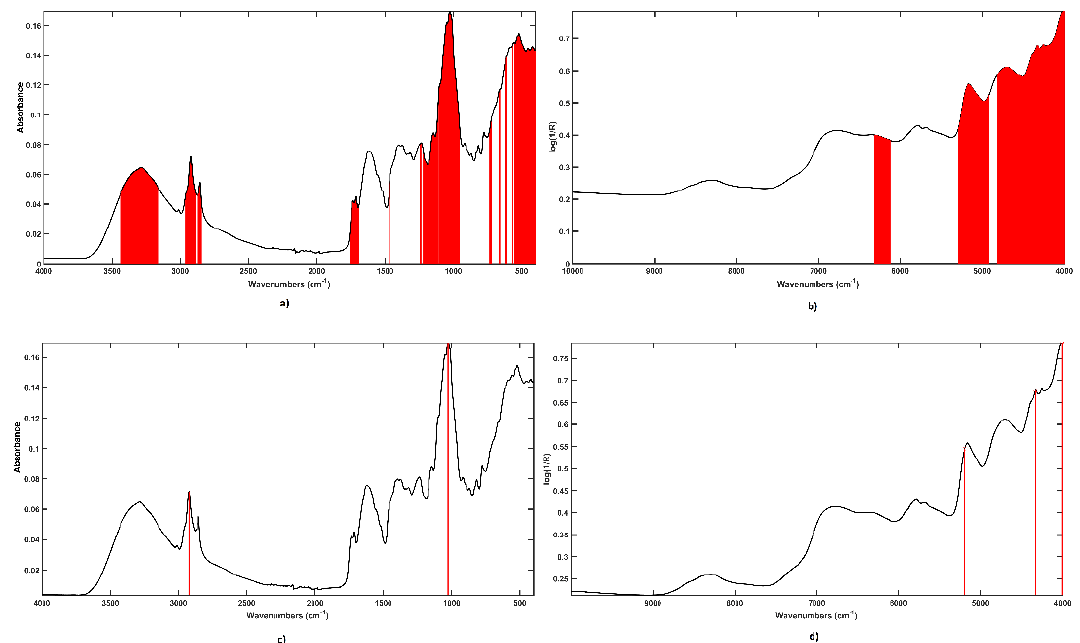
Figure 3. SO-PLS-LDA: MIR ( a ) and NIR ( b ) variables identified as relevantly contributing to the model based on the value of their variable importance in projection (VIP) score (highlighted in red). Sequential and orthogonalized covariance selection linear discriminant analysis (SO-CovSel-LDA): MIR ( c ) and NIR ( d ) variables selected by the model. In all cases, the mean spectroscopic profiles are displayed as black continuous line.